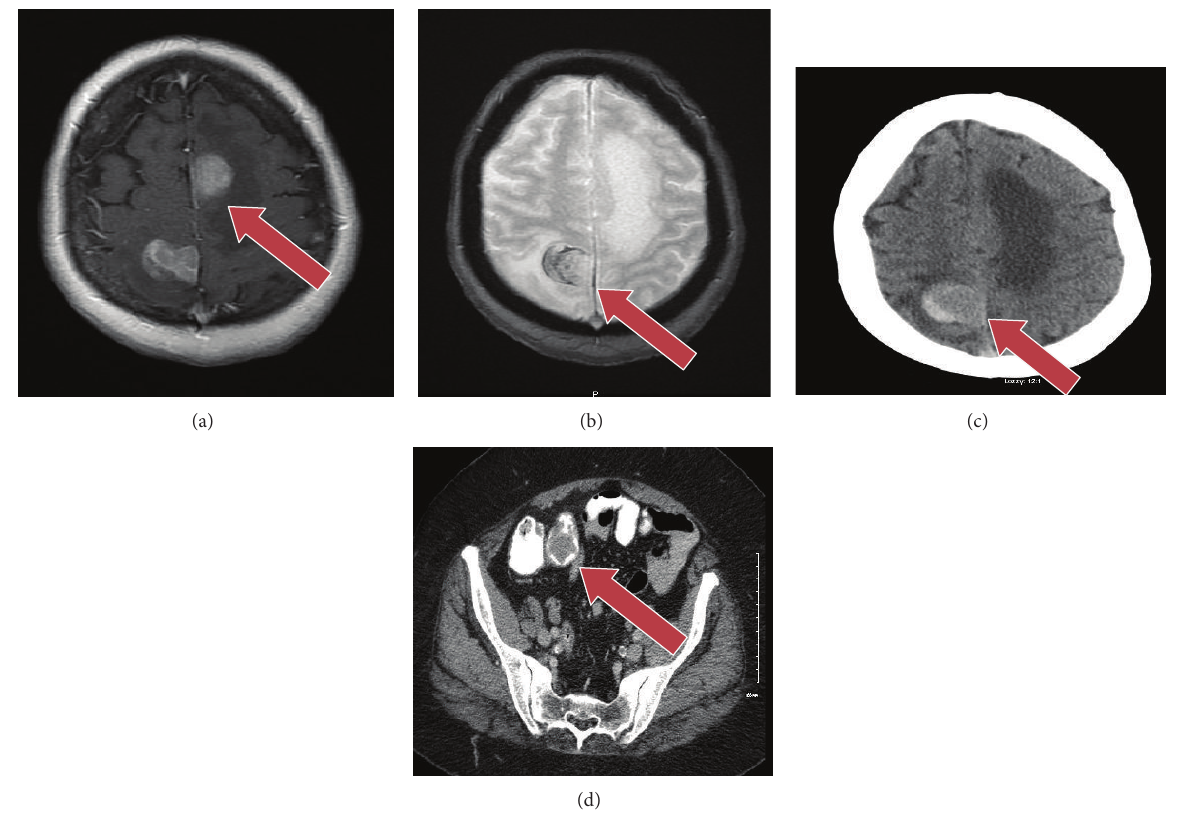
Figure 1: (a), (b), (c) Arrows showing MRI of brain with and without gadolinium with metastatic lesions in parietal and occipital region. (d) Showing CT scan of abdomen and pelvis with filling defect in terminal